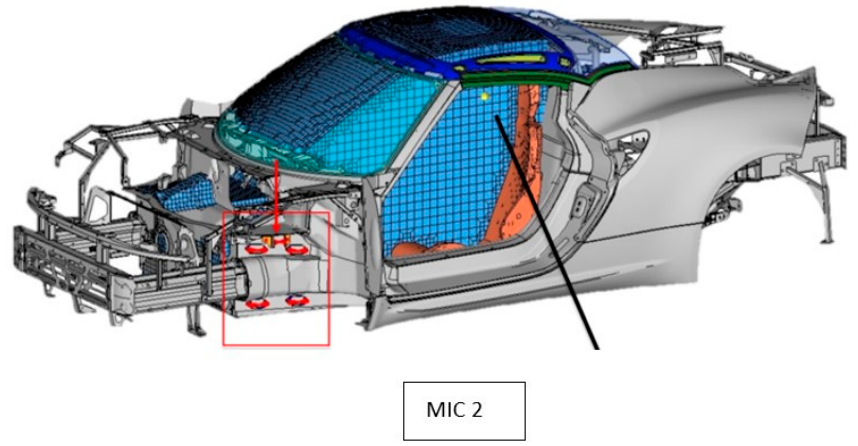
Figure 27. Vibroacoustic transfer functions (TF) from the car roof center to the ear node for TCA (black line) and PP23CF OPTIMIZED (red line).